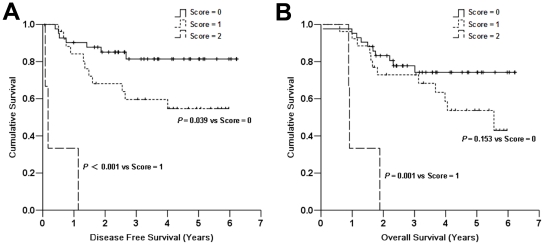
The prognostic value of the preoperative prognostic score model for patients without vascular invasion.The Kaplan-Meier curves showed there was a significant difference in DFS (A) and OS (B) between patients with a score of 2 and patients with a score of 0 or 1.